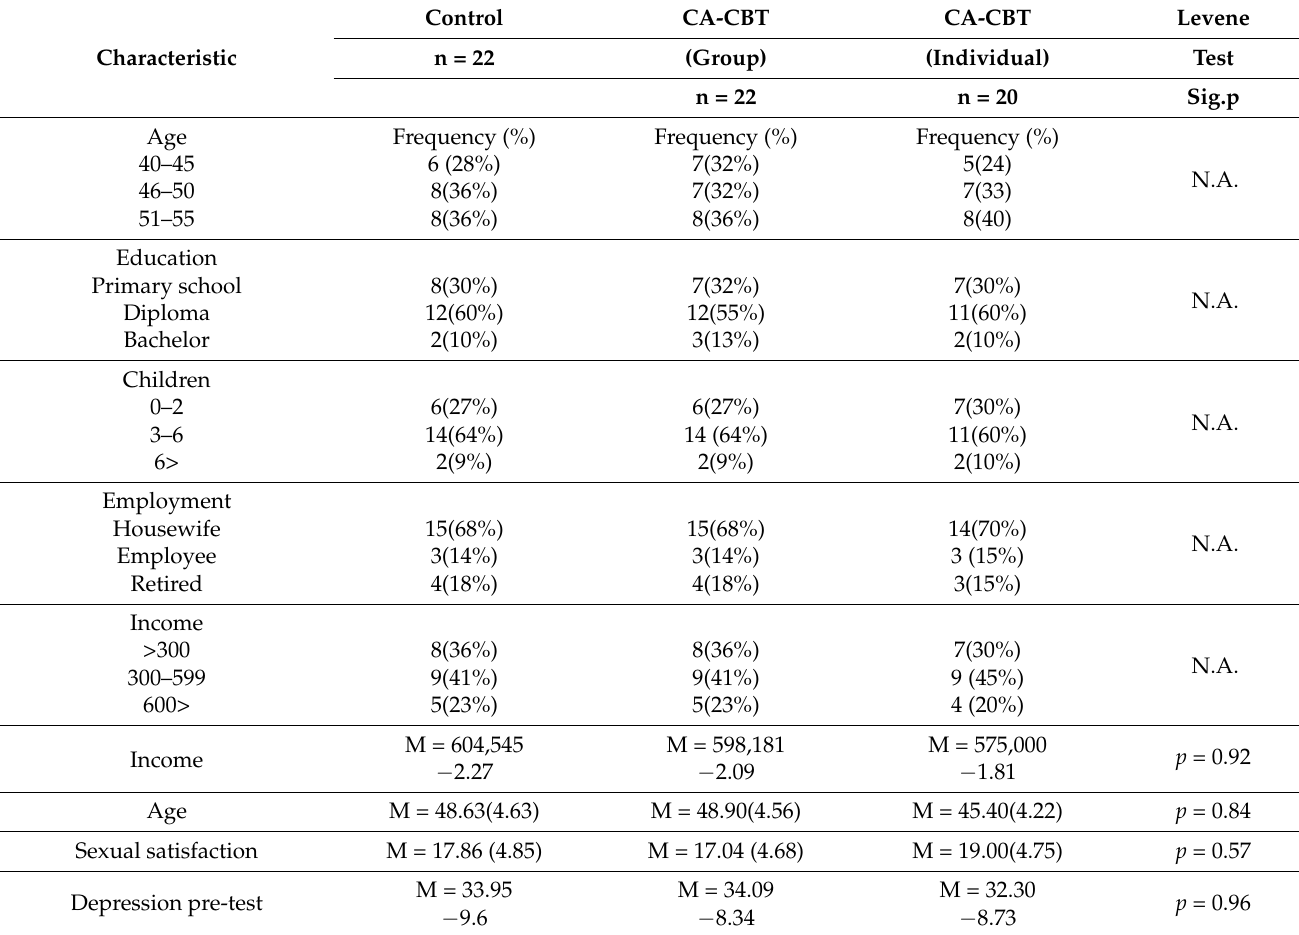
Table 2. Sample characteristics of the three